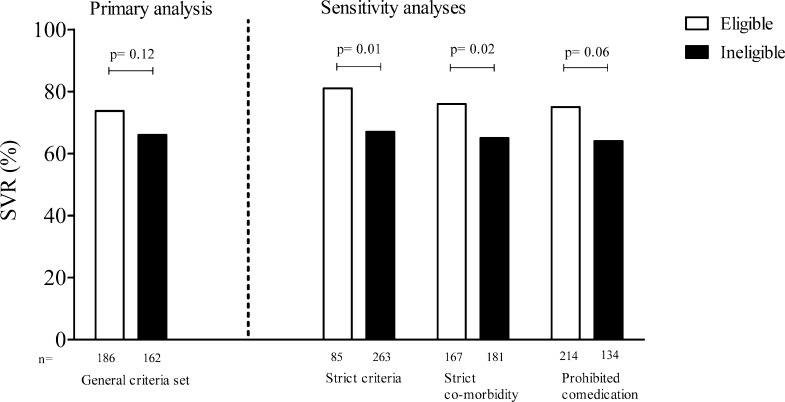
Effectiveness in real world treatment naive and relapse patients who would be eligible and ineligible for registration trials.Primary and sensitivity analyses on effectiveness of therapy in eligible vs. ineligible naive and relapse patients (n = 348). The bars represent the proportion of patients who reached a sustained virological response (SVR) within the groups. For sensitivity analyses different criteria sets are used to determine eligibility of patients, hence different numbers of patients in both groups.